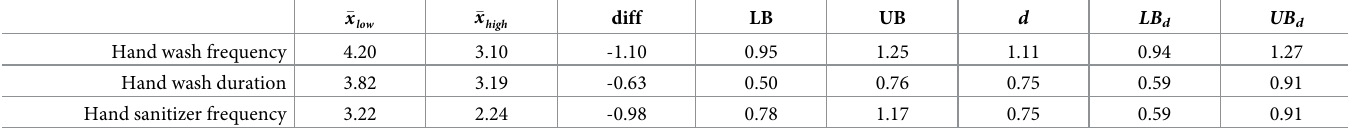
Table 5. Descriptive statistics for the raw values, 1–5, for the three behavior answers. This coding ignores the verbal labels, so these differences show some people pay attention to the labels.